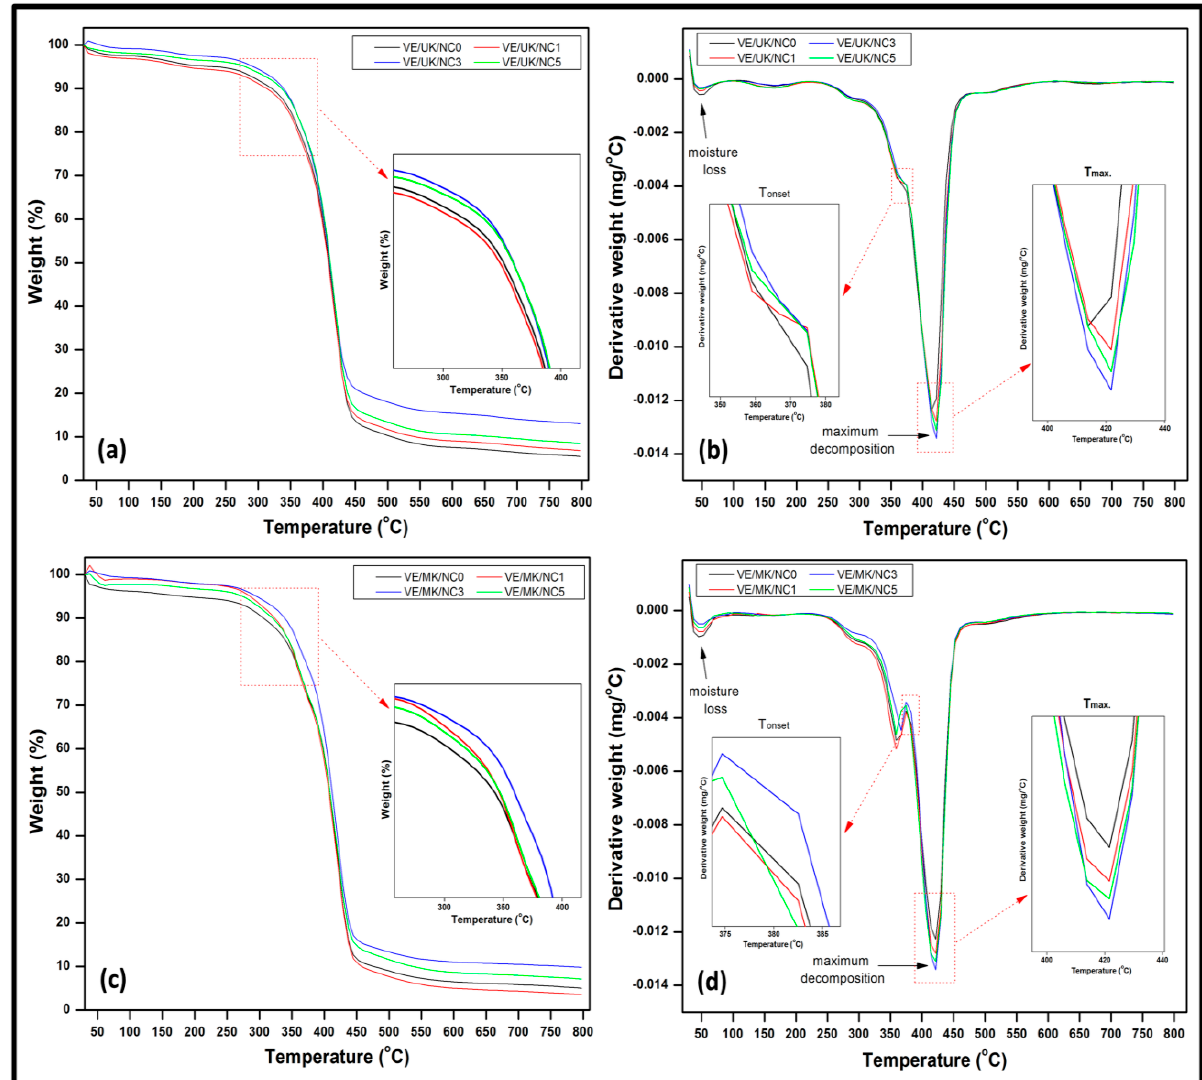
Figure 11. Thermal properties of ( a ) TGA profile of unmodified nanocomposite ( b ) DTG profile of unmodified nanocomposite ( c ) TGA profile of modified nanocomposite ( d ) DTG profile of modified nanocomposite.